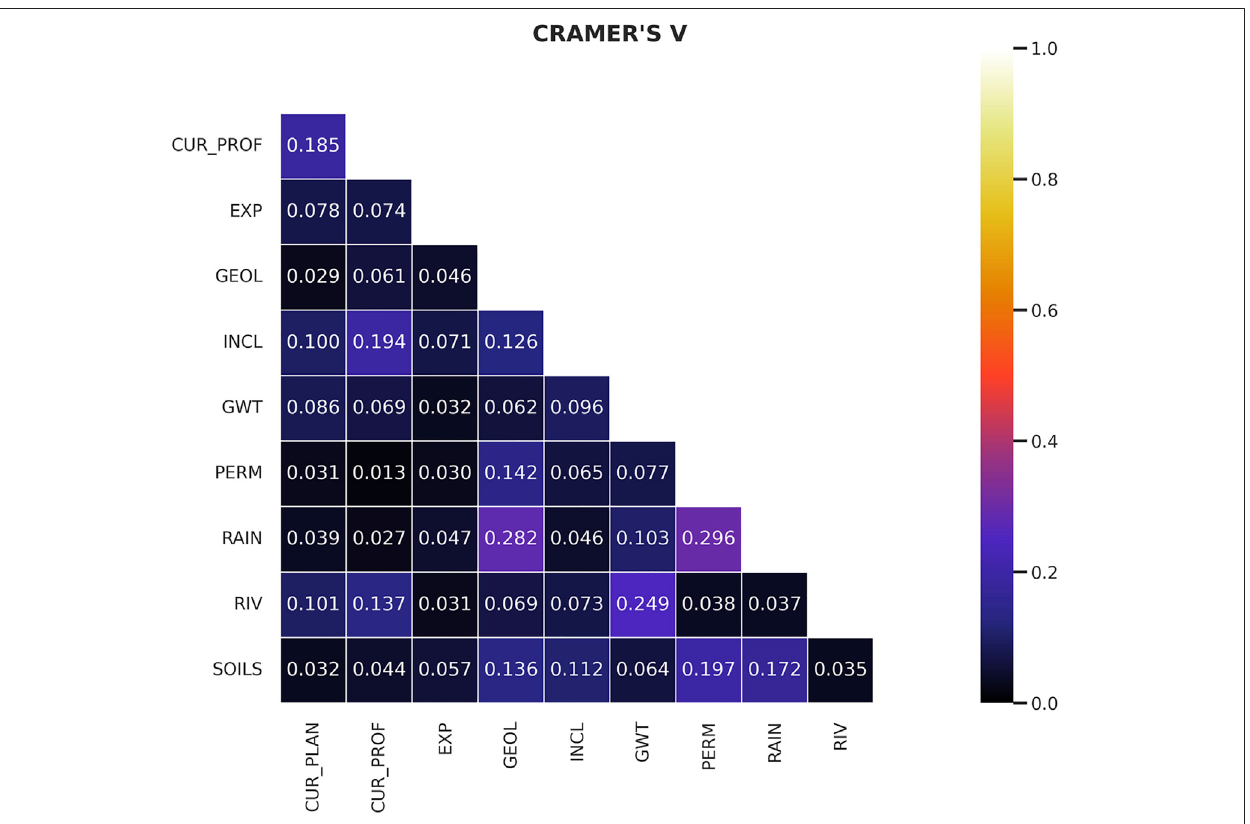
FIGURE 5 | Matrix of Cramer ’ s